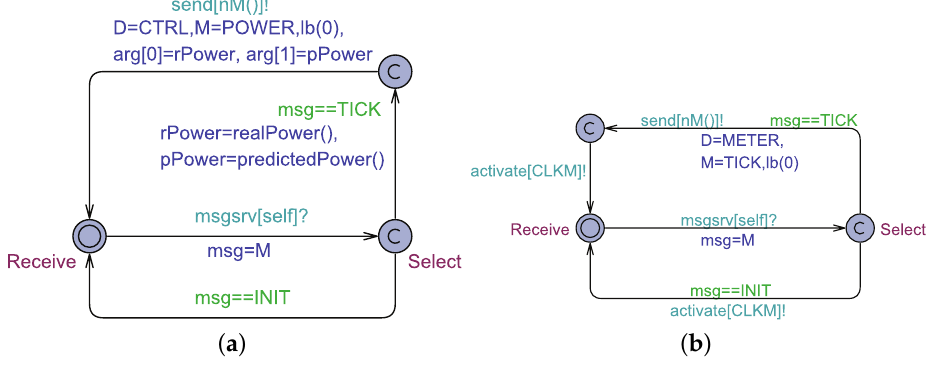
Figure 9. The Meter ( a ) and the Clock ( b )